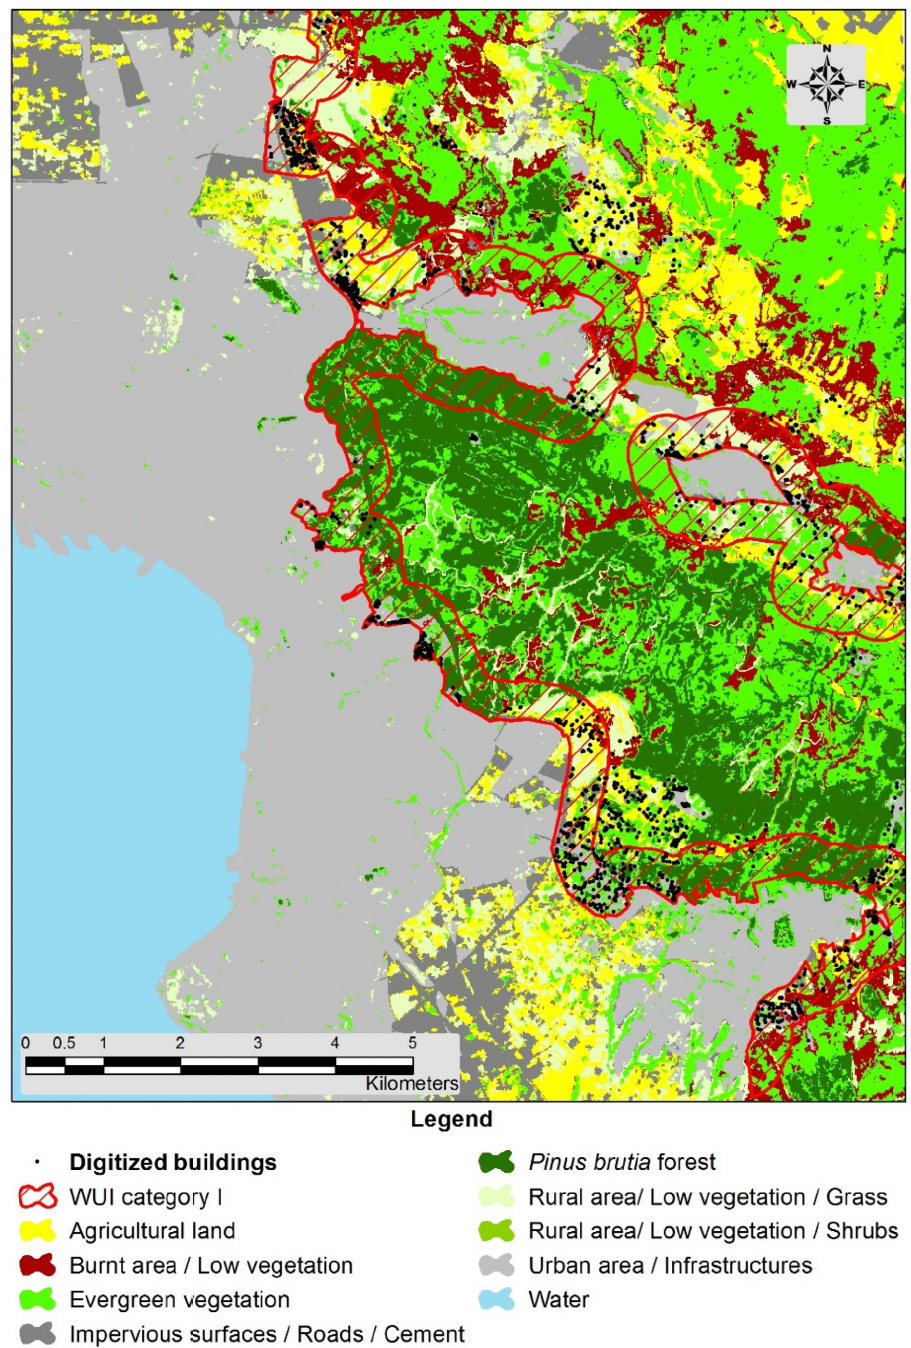
Figure 2. OBIA classification results of study area using Sentinel-2 image background (pixel size 10 m). WUI category I (buffer 500 m outside urban areas) is also presented. Dots represent